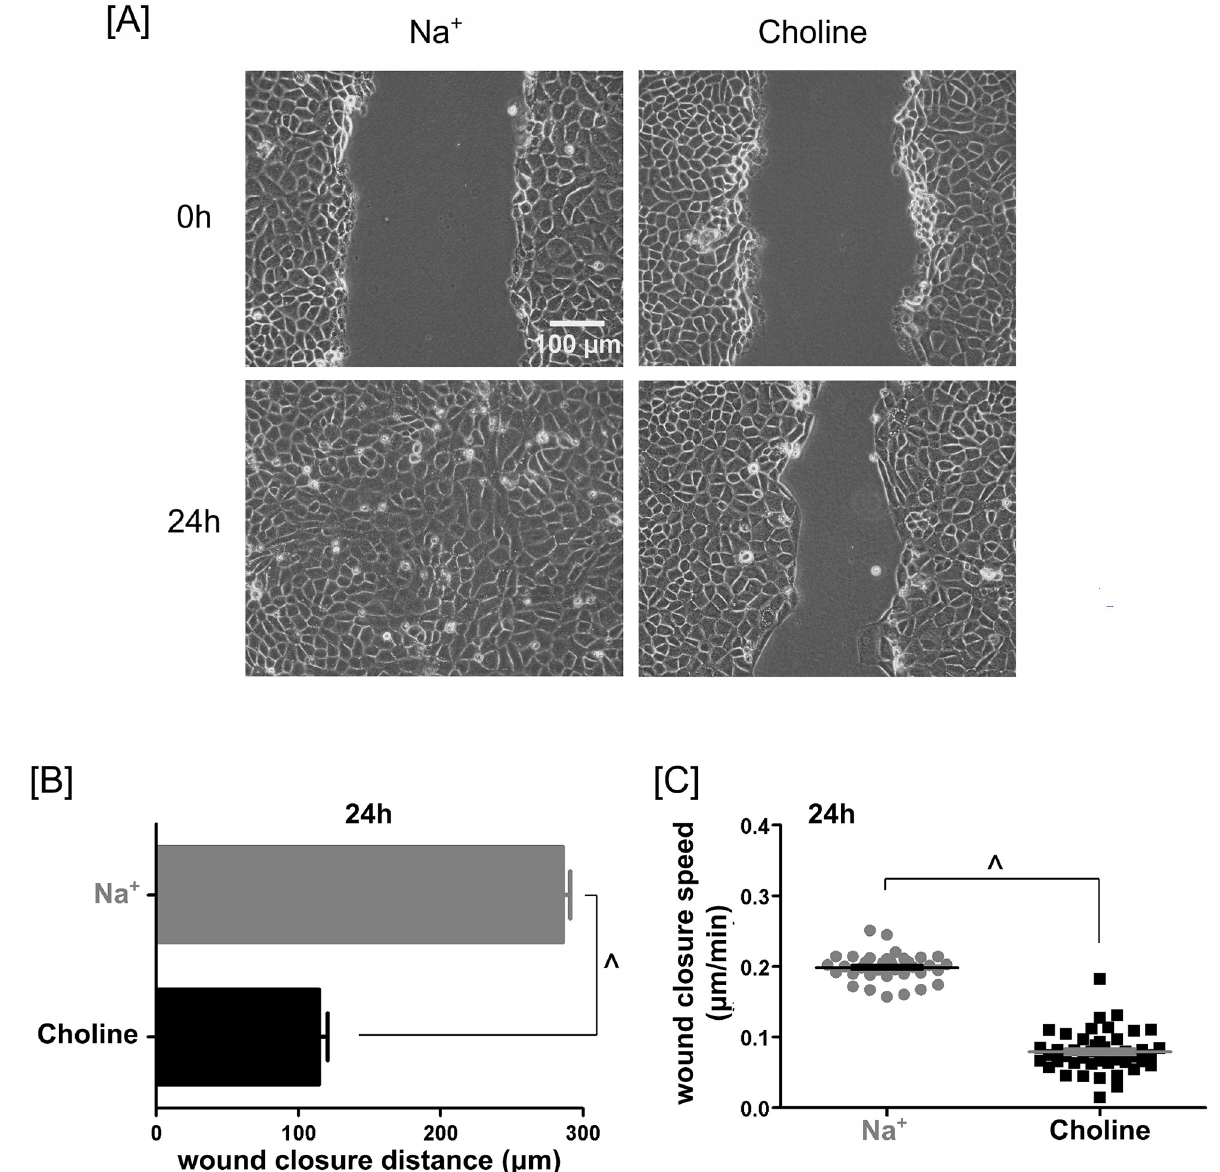
Fig 1. Contribution of extracellular Na + to PAECs scratch wound closure. (A) Phase-contrast images of PAEC monolayers. The top and bottom rows showed monolayers immediately after and 24 hours after scratching, respectively. The monolayers in the left and right columns were in a Na + - and choline-containing media, respectively. In the absence of extracellular Na + , wound closure was incomplete at 24 hours. (B) Bar plot of average wound closure distances over 24 hours in Na + - and choline-containing media. Over 24 hours, extracellular Na + enabled PAECs to migrate farther. (C) Scatter plot of wound closure speeds in both Na + - and choline-containing media. The migration speed of PAECs was significantly slower in the absence of extracellular Na + when compared to the Na + -containing counterpart. Both the bar plot and scatter plot showed mean ± SEM. Statistical significance was assessed using unpaired t -test with Welch’s correction (^— P <